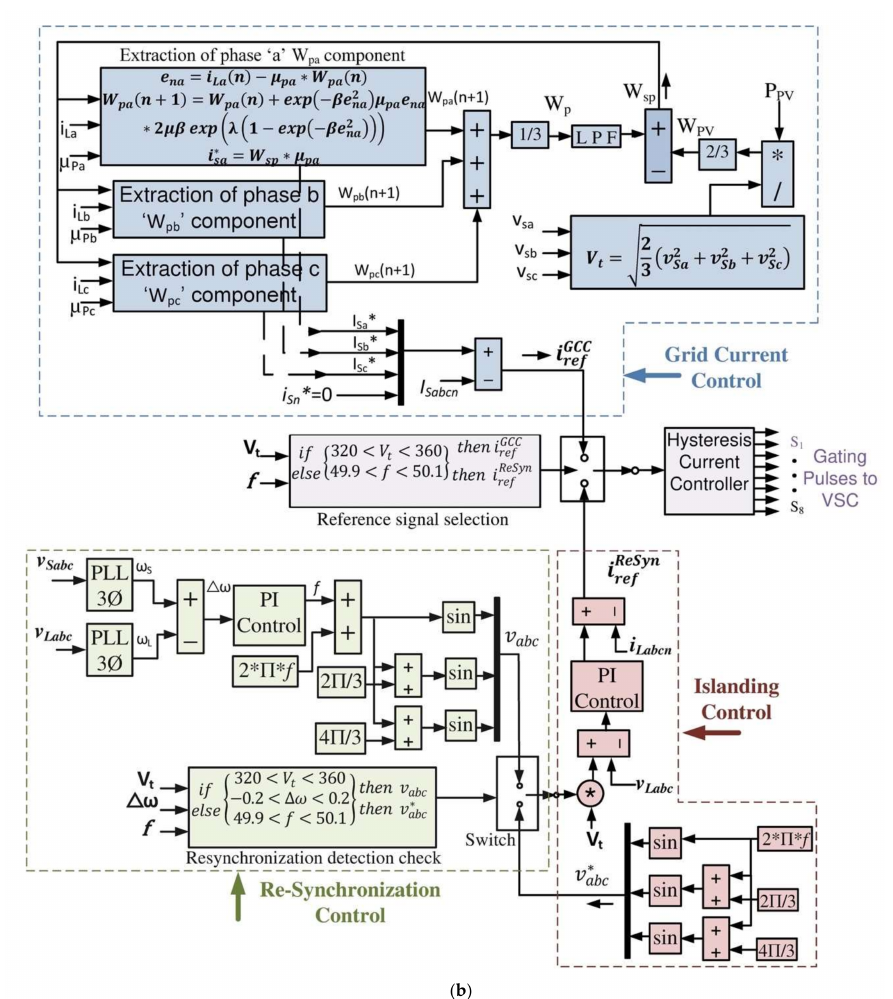
Figure 2. ( a ) Research methodology. ( b ) Voltage source converter (VSC) control based on the NysMKRSL